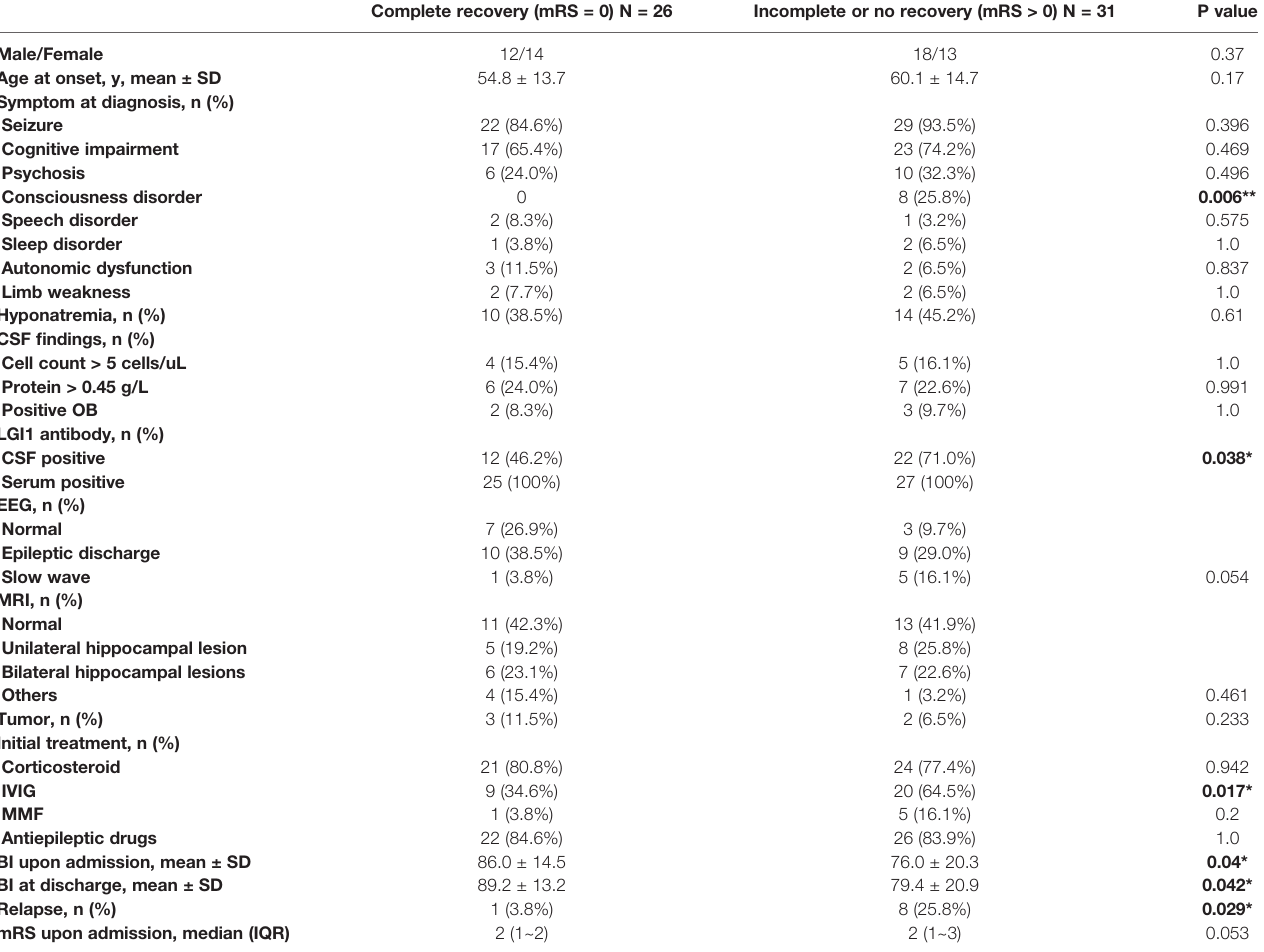
TABLE 2 | Comparison between patients with complete recovery and those experiencing incomplete or no recovery at 12 months after